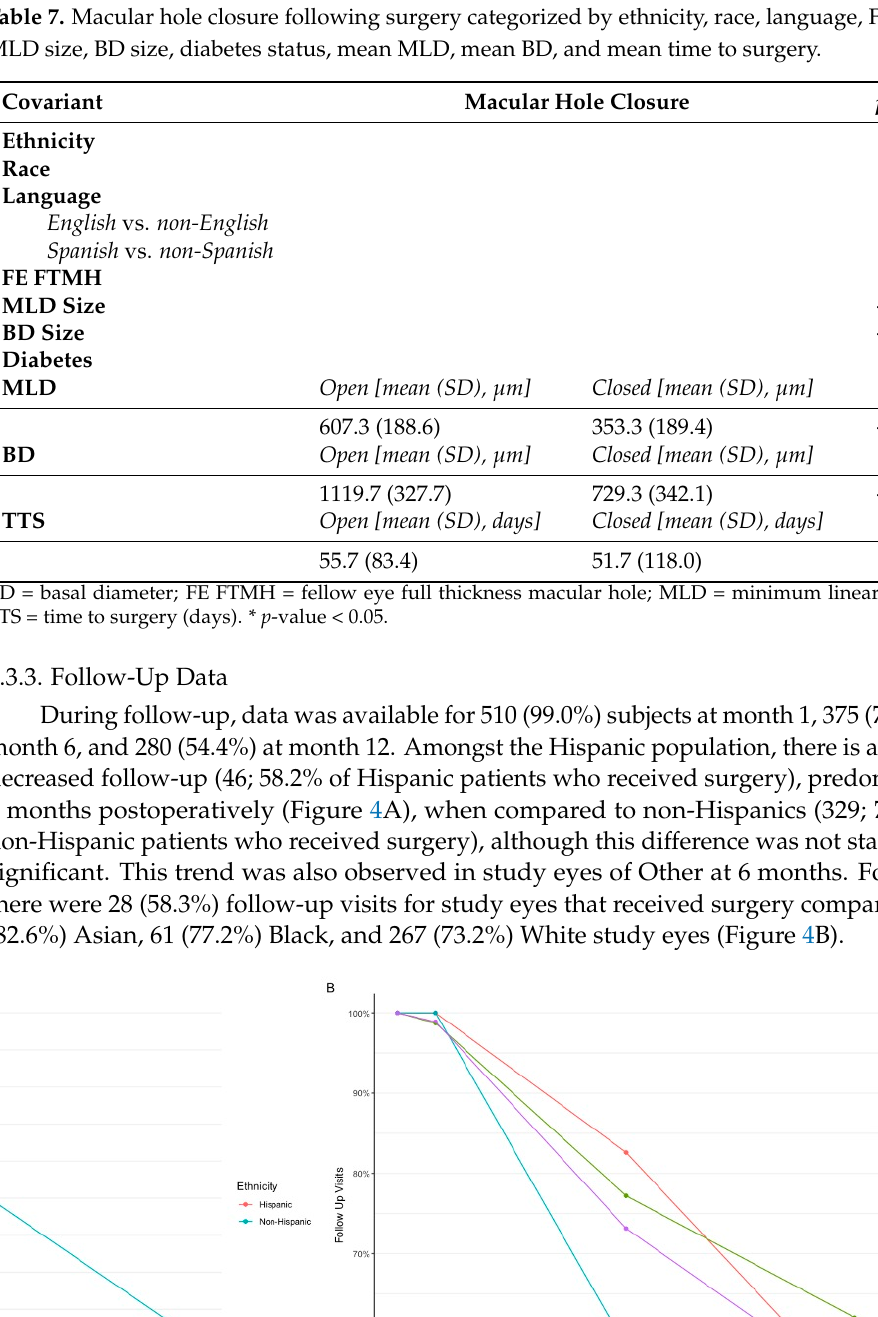
Table 7. Macular hole closure following surgery categorized by ethnicity, race, language, FE FTMH, MLD size, BD size, diabetes status, mean MLD, mean BD, and mean time to surgery. Covariant